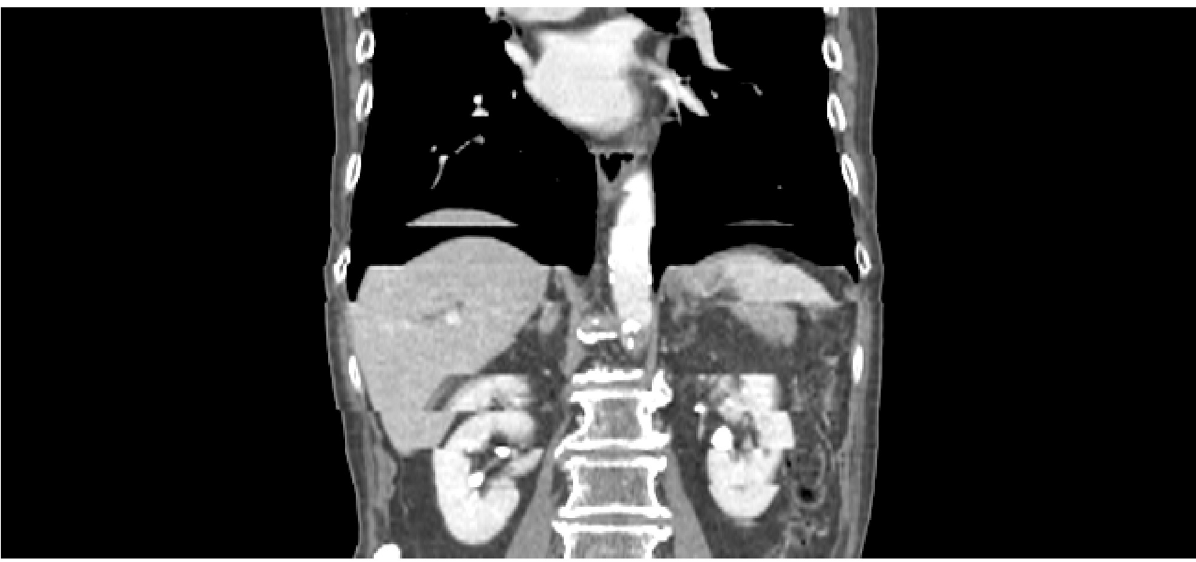
Fig 1. Illustration of RMA in coronal view of cine-mode